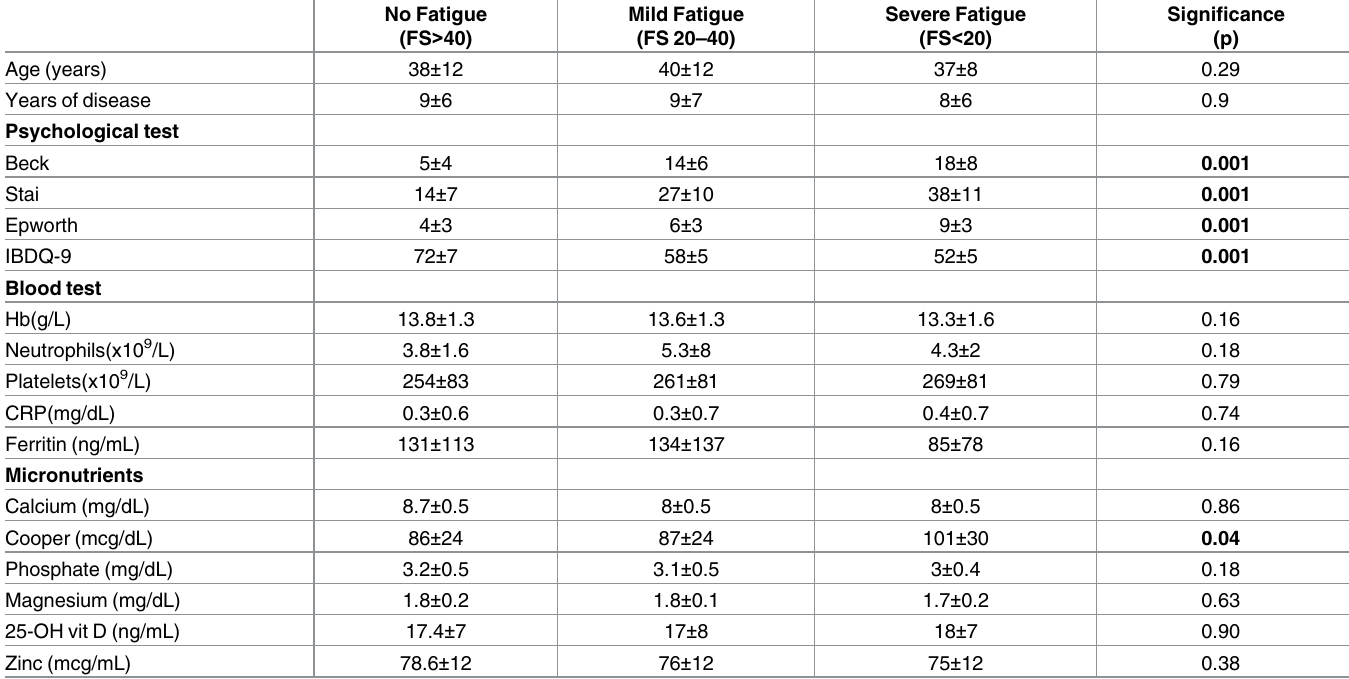
Table 3. Relationship between fatigue and biological and psychological variables: Univariate